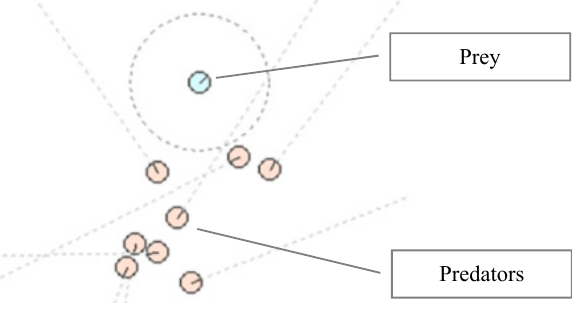
Figure 2. Sample initial situation.